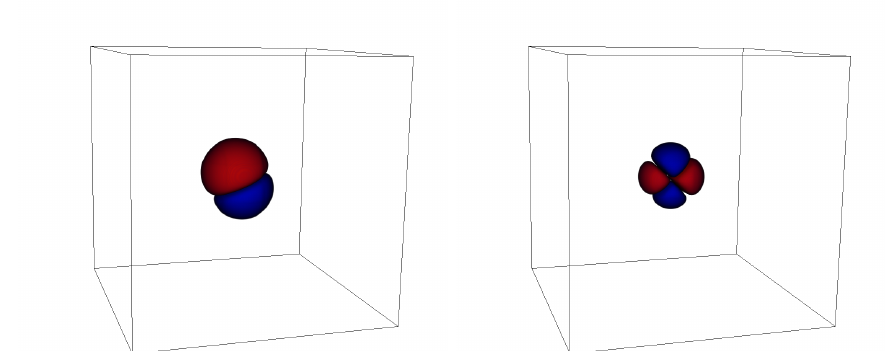
Figure 11 . Charge densities of complex CSQs with unequal charges at t = 1 . 5 × 10 5 . In the left plot, we initially superimpose an anti-Q-ball with ω = − 2 . 0 and a Q-ball with ω = 2 . 0 but with its amplitude deformed by a factor of 1.2, located at (0 , 1 , 0) and (0 , − 1 . 0 , 0) respectively. In the right plot, we initially superimpose two of these anti-Q-balls and two of these deformed Q-balls, located symmetrically from the center with a distance of